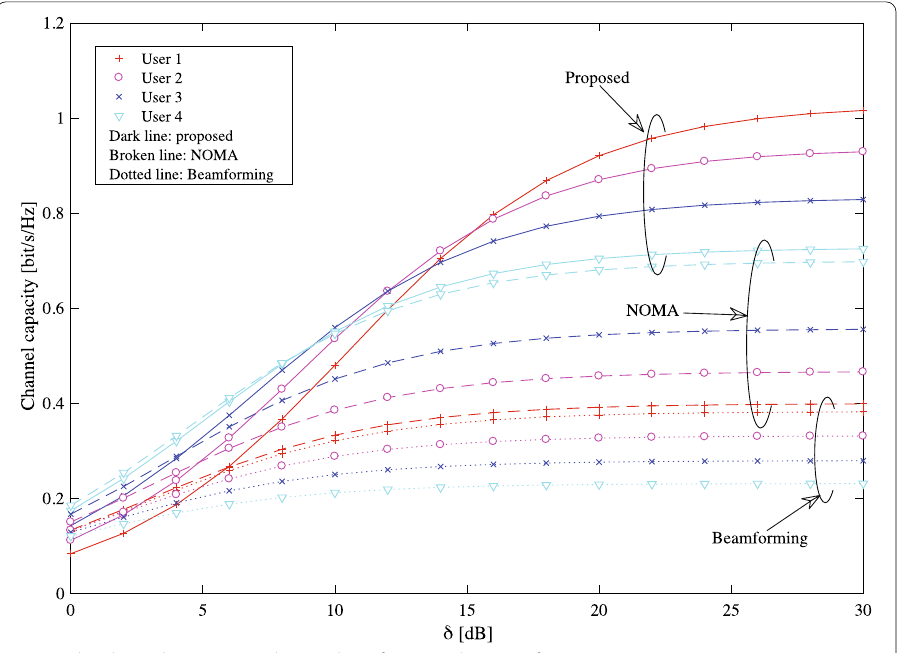
Fig. 3 The channel capacity via the number of users in the case of (cid:31) K = 0dB , K =